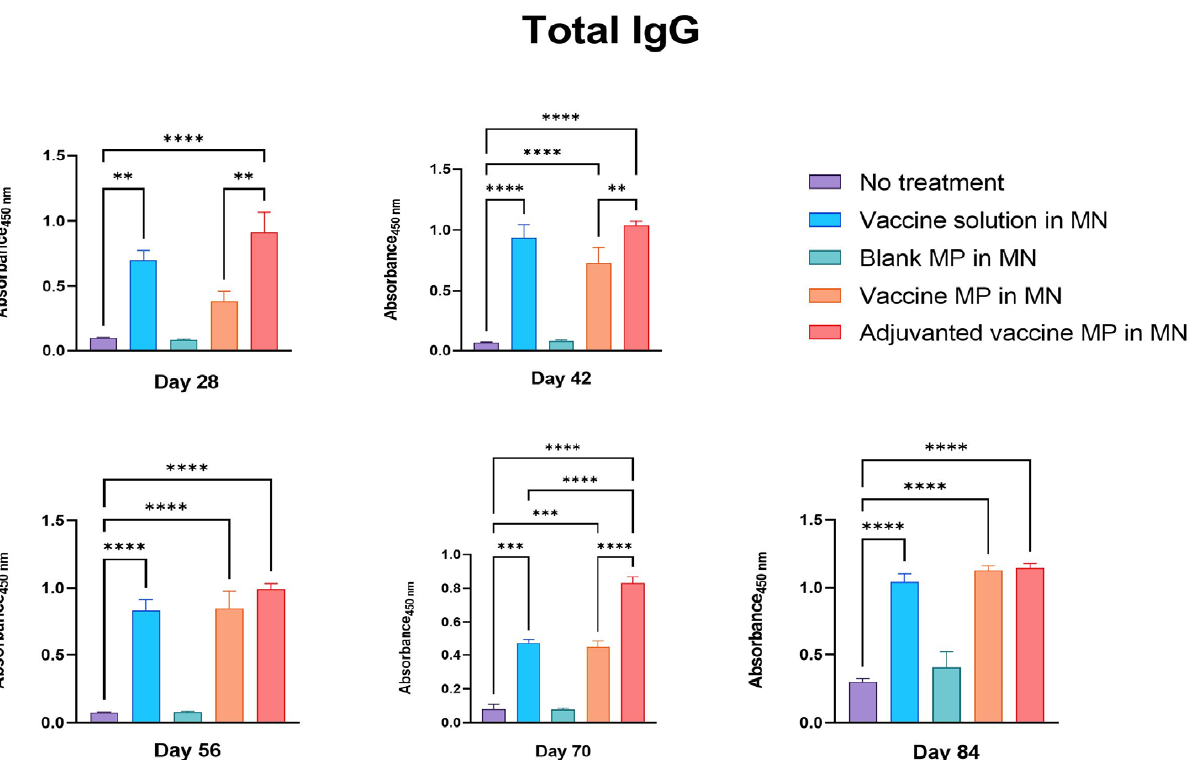
Figure 4. Measurement of Zika-specific total IgG in serum using ELISA. Mice were immunized with